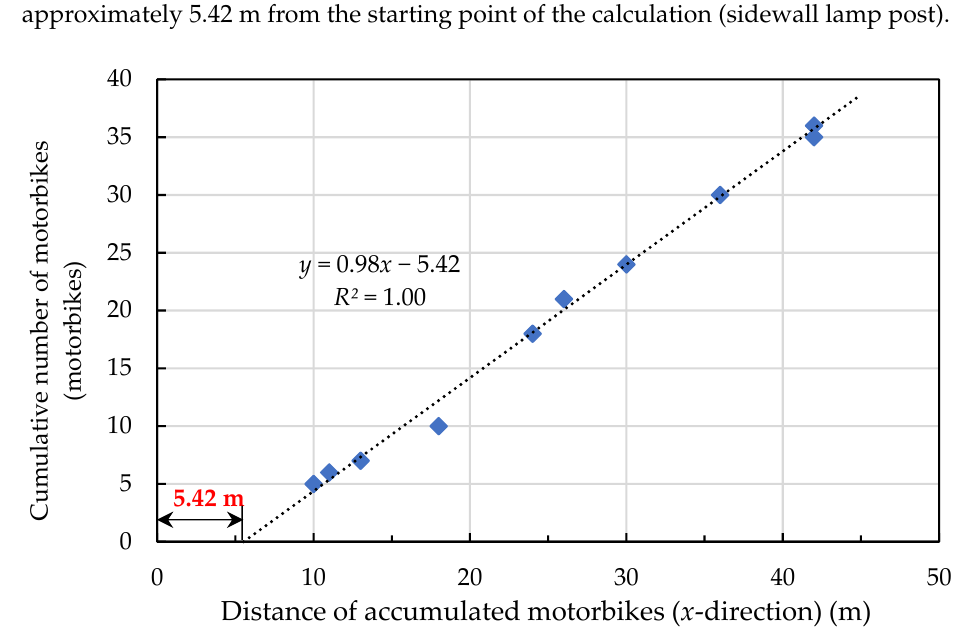
Figure 6. The cumulative number of motorbikes and corresponding accumulated distance.